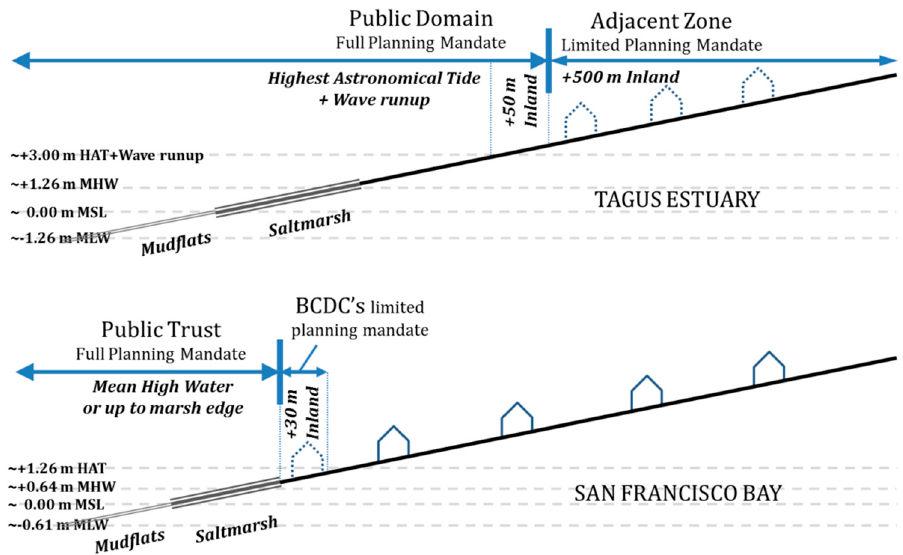
Figure 5. Definition of Public Trust/Public Domain and additional planning mandates in the Tagus Estuary and the San Francisco